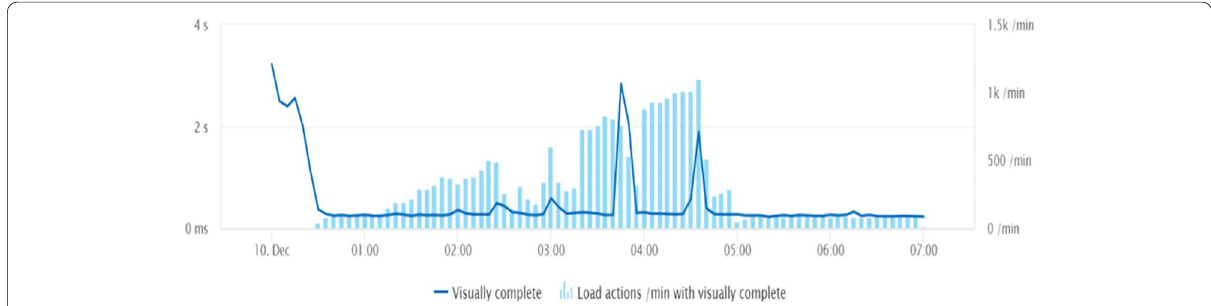
Fig. 12 Microservice response time vs. the number of requests